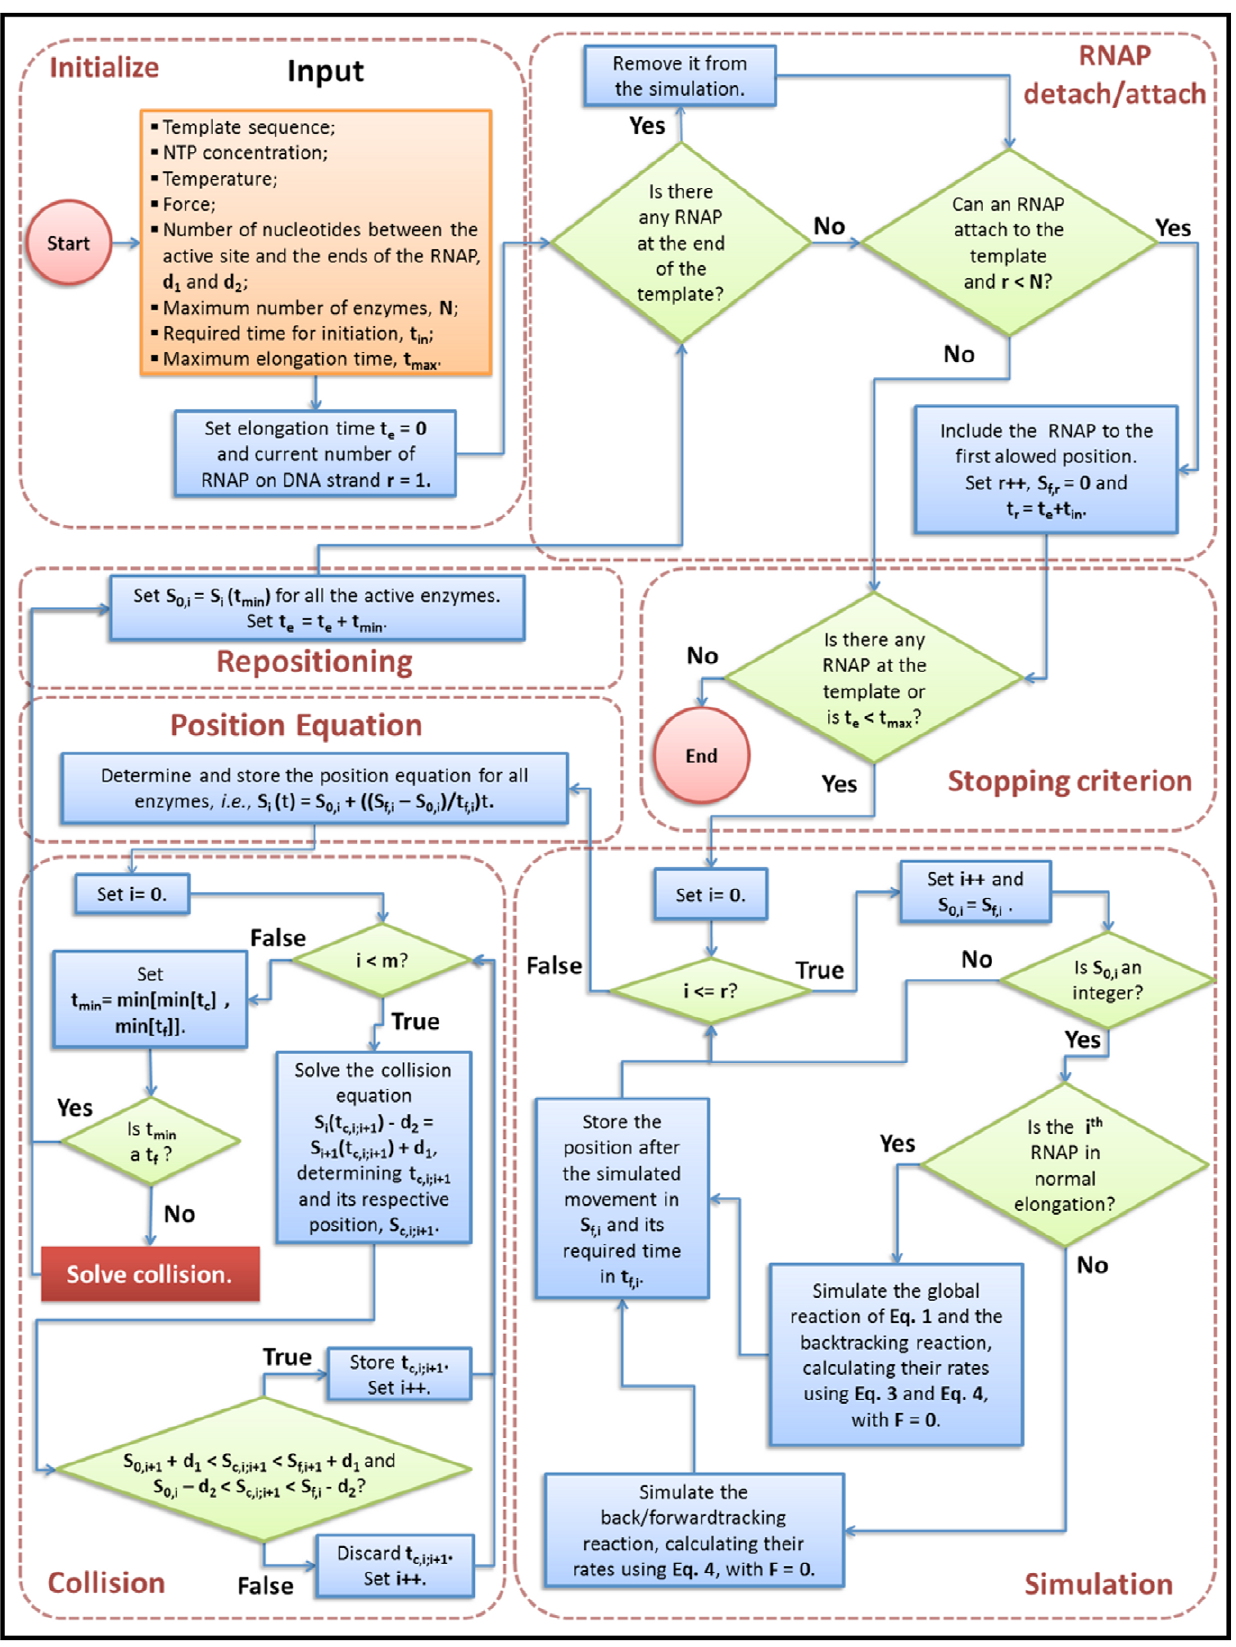
Figure 3. Diagram representing the overall algorithm: The subroutine ‘‘Solving collision’’ is described in Figure 4 . doi:10.1371/journal.pone.0057328.g003 PLOS ONE |